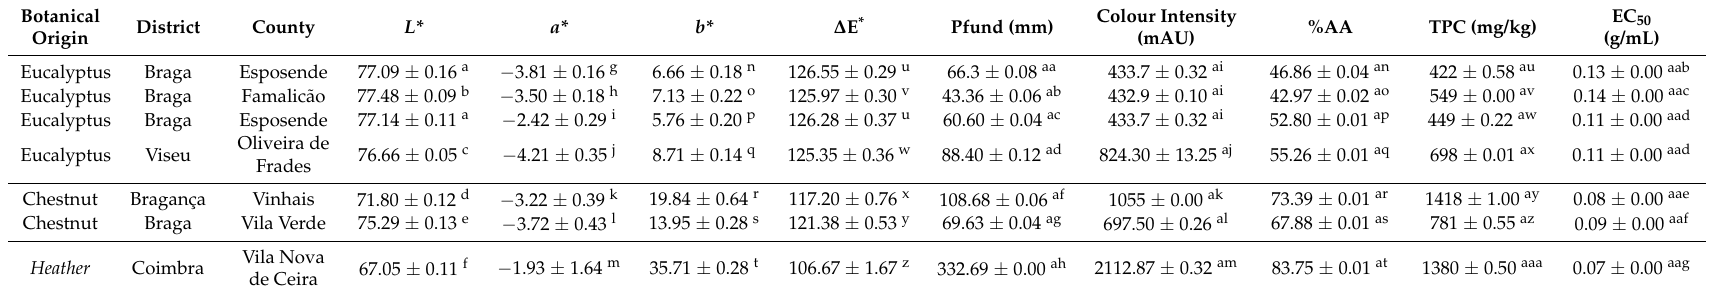
Different letters (superscripts) in each column represent statistically significant differences at the confidence level p < 0.05. Superscripts have been inserted according to the hierarchy in lettering of the alphabet. Standard deviation values of EC 50 were below 10 − 4 . Therefore, these were considered as zeros. Results reported are the average ± standard deviation values of three replicates ( n =